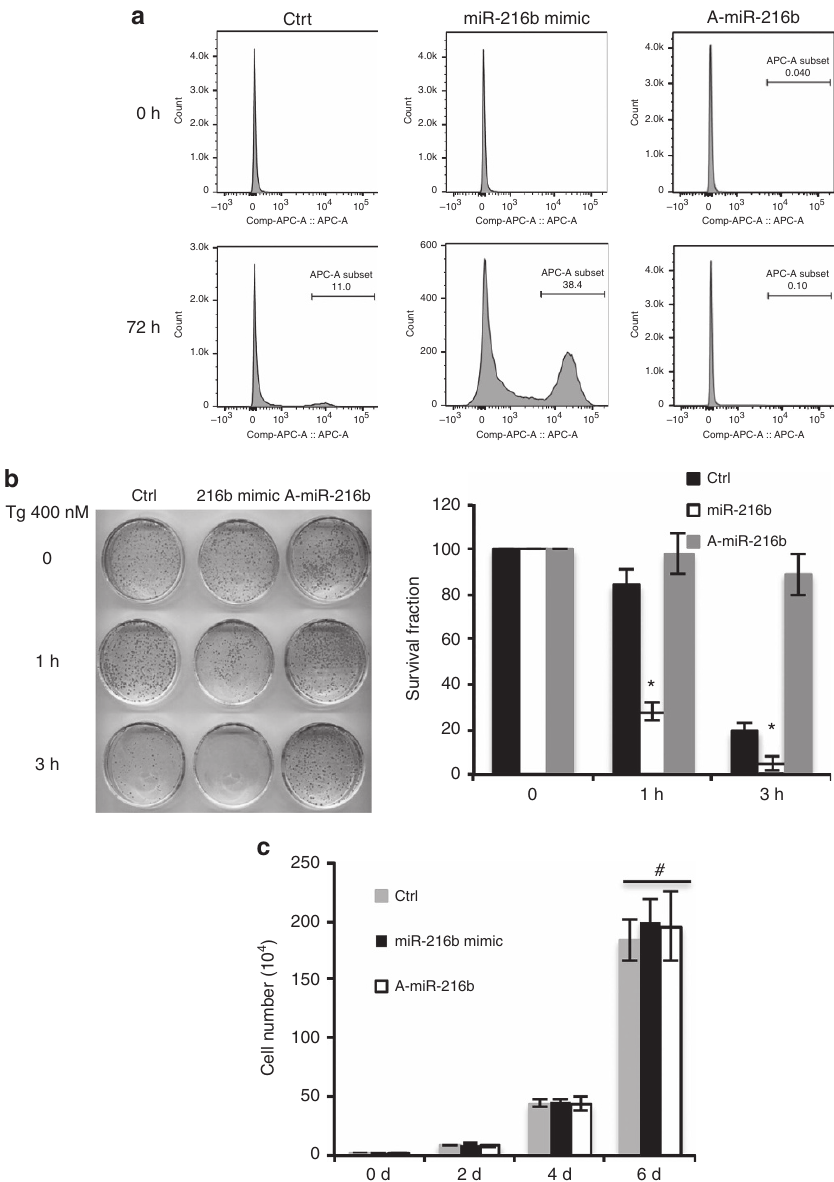
Figure 6 | MiR-216b expression sensitizes cells to ER stress. ( a ) Representative FACS analysis histograms of U2OS stable cells expressing control, miR- 216b or A-miR-216b after treatment with 500nm TG. ( b ) U2OS cells stably expressing control, miR-216b or A-miR-216b were plated and treated with 400nM TG for 1 or 3h, and then returned to normal growth medium for 12 days (d). Plates were assessed for colony formation by staining with Giemsa staining (left). Quantification of colonies (right). ( c ) Cell doubling was quantified over 6 days. Values are means ± s.d. ( n ¼ 3) and statistical significance was analysed by Student’s t -test. (* P o 0.05; # P 4 0.05).